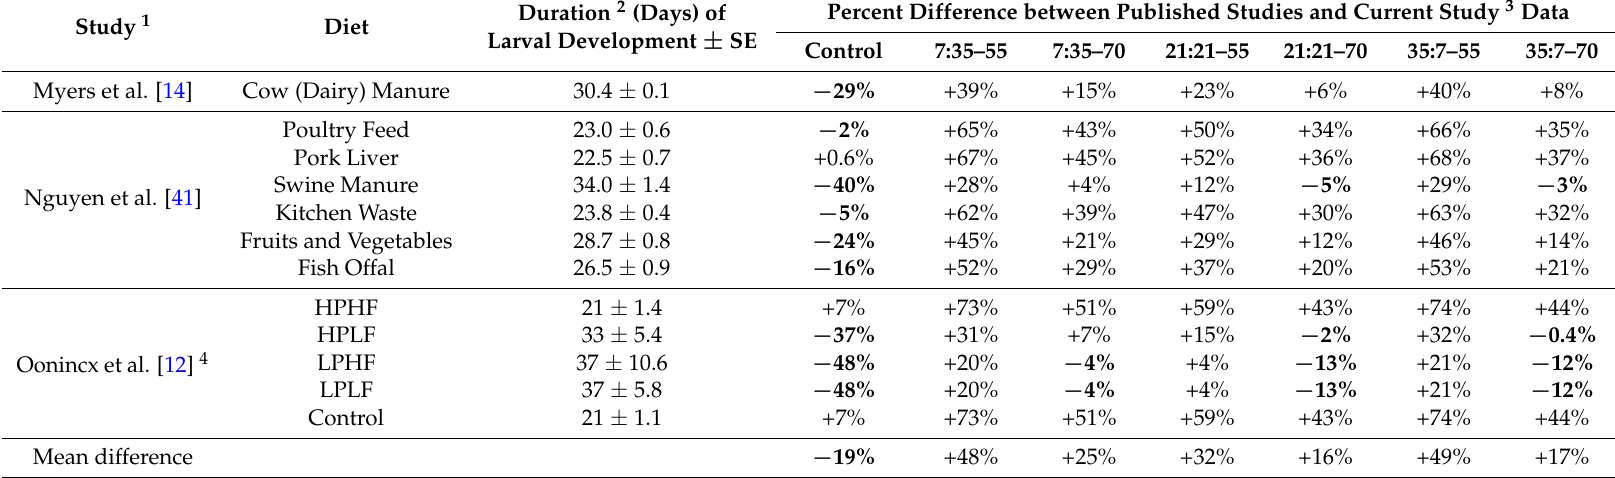
Table 3. Percent difference in black soldier fly larval development from three previous studies to data generated in the current